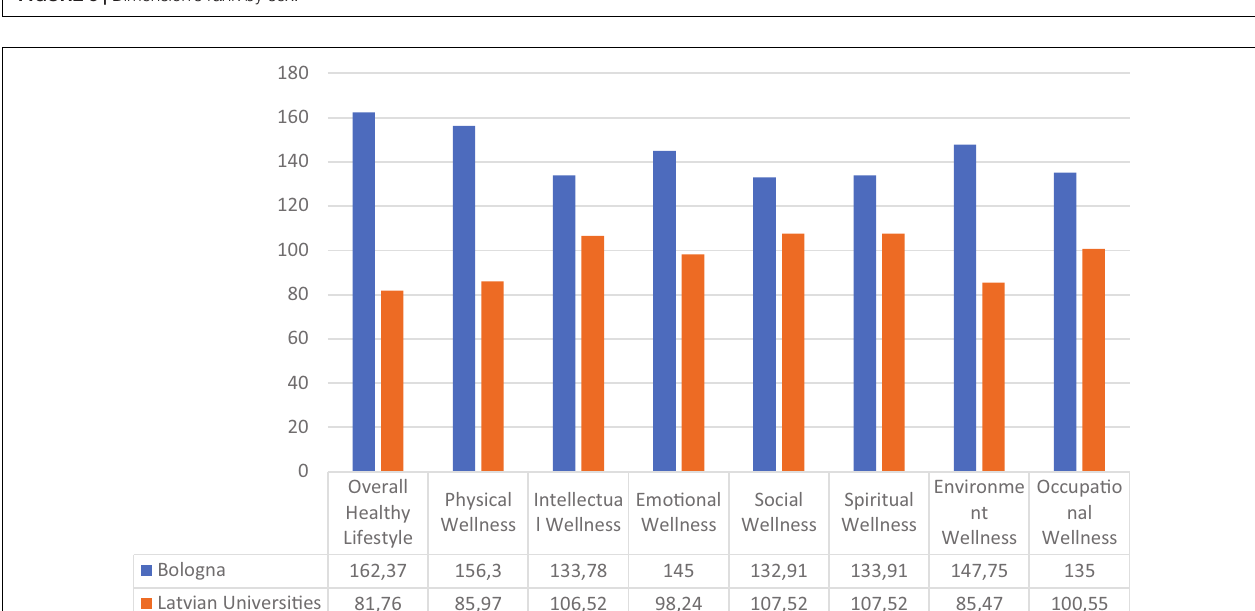
FIGURE 3 | Dimension’s rank by sex.